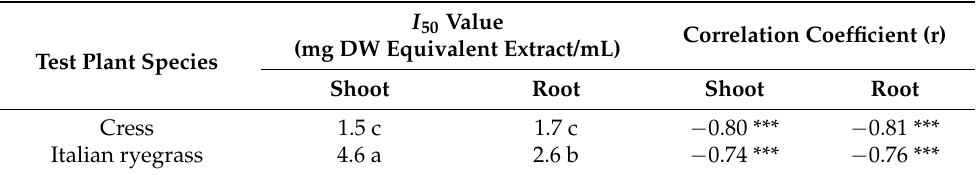
Table 1. I 50 values (mg DW equivalent extract/mL) and correlation coefficient (r) of the shoot and root growth of the test plant species by the aqueous methanol extracts of Marsdenia tenacissima . Different letters indicate significant difference between the treatments according to Tukey’s HSD test ( p < 0.05), and asterisks in correlation coefficient denote statistical significance: *** p < 0.001.